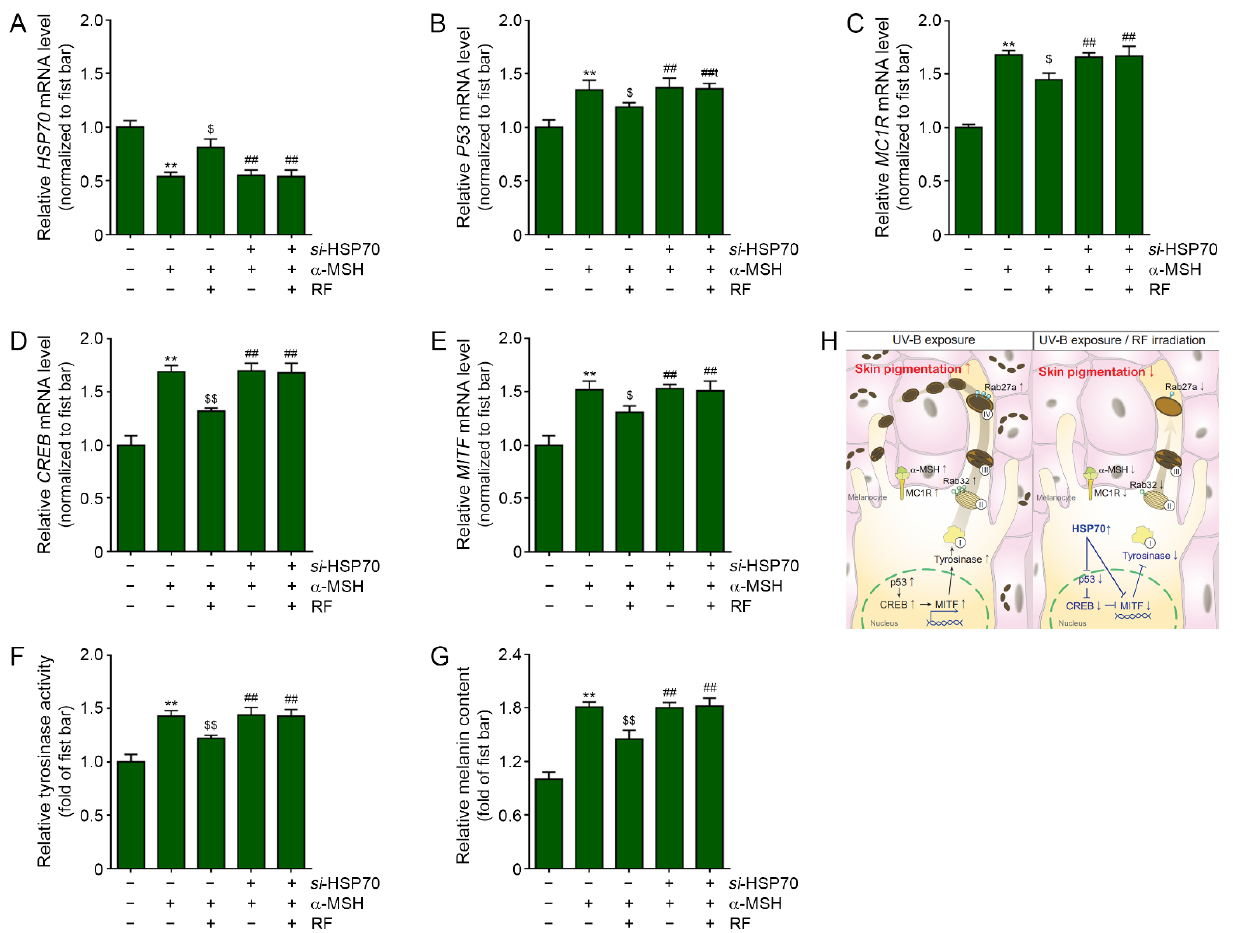
Figure 5. Effects of RF on decreasing melanogenesis in HSP70-silenced HEMn cells ( A – E ). HSP70 ( A ), p53 ( B ), MC1R ( C ), CREB ( D ), and MITF ( E ) mRNA levels of α -MSH and si-HSP70 or untreated melanocytes were evaluated using qRT-PCR. ( F ) Relative tyrosinase activity of α -MSH and si-HSP70 treated melanocytes were evaluated by ELISA. ( G ) Relative melanin content of α -MSH and si-HSP70 treated melanocytes were evaluated by melanin content assay. ( H ) Summary of this study. HSP70, 70 kilodalton heat shock proteins; MC1R, melanocortin 1 receptor; MITF, microphthalmia-associated transcription factor; Rab32, ras-related protein Rab-32; Rab27a, ras-related protein Rab-27a; RF, radiofrequency; UV-B, ultraviolet-B; **: p < 0.01 vs. PBS; ##: p < 0.01 vs. α -MSH; $: p < 0.05 vs. α -MSH/RF; $$: p < 0.01 vs. α -MSH/RF.